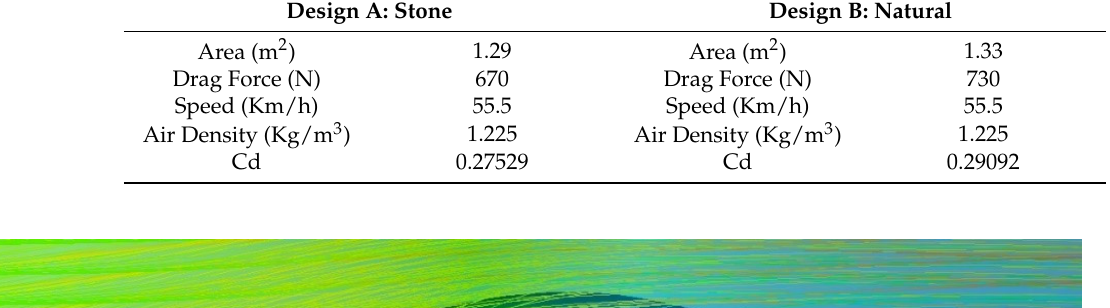
Table 1. CFD Parameters and Results.